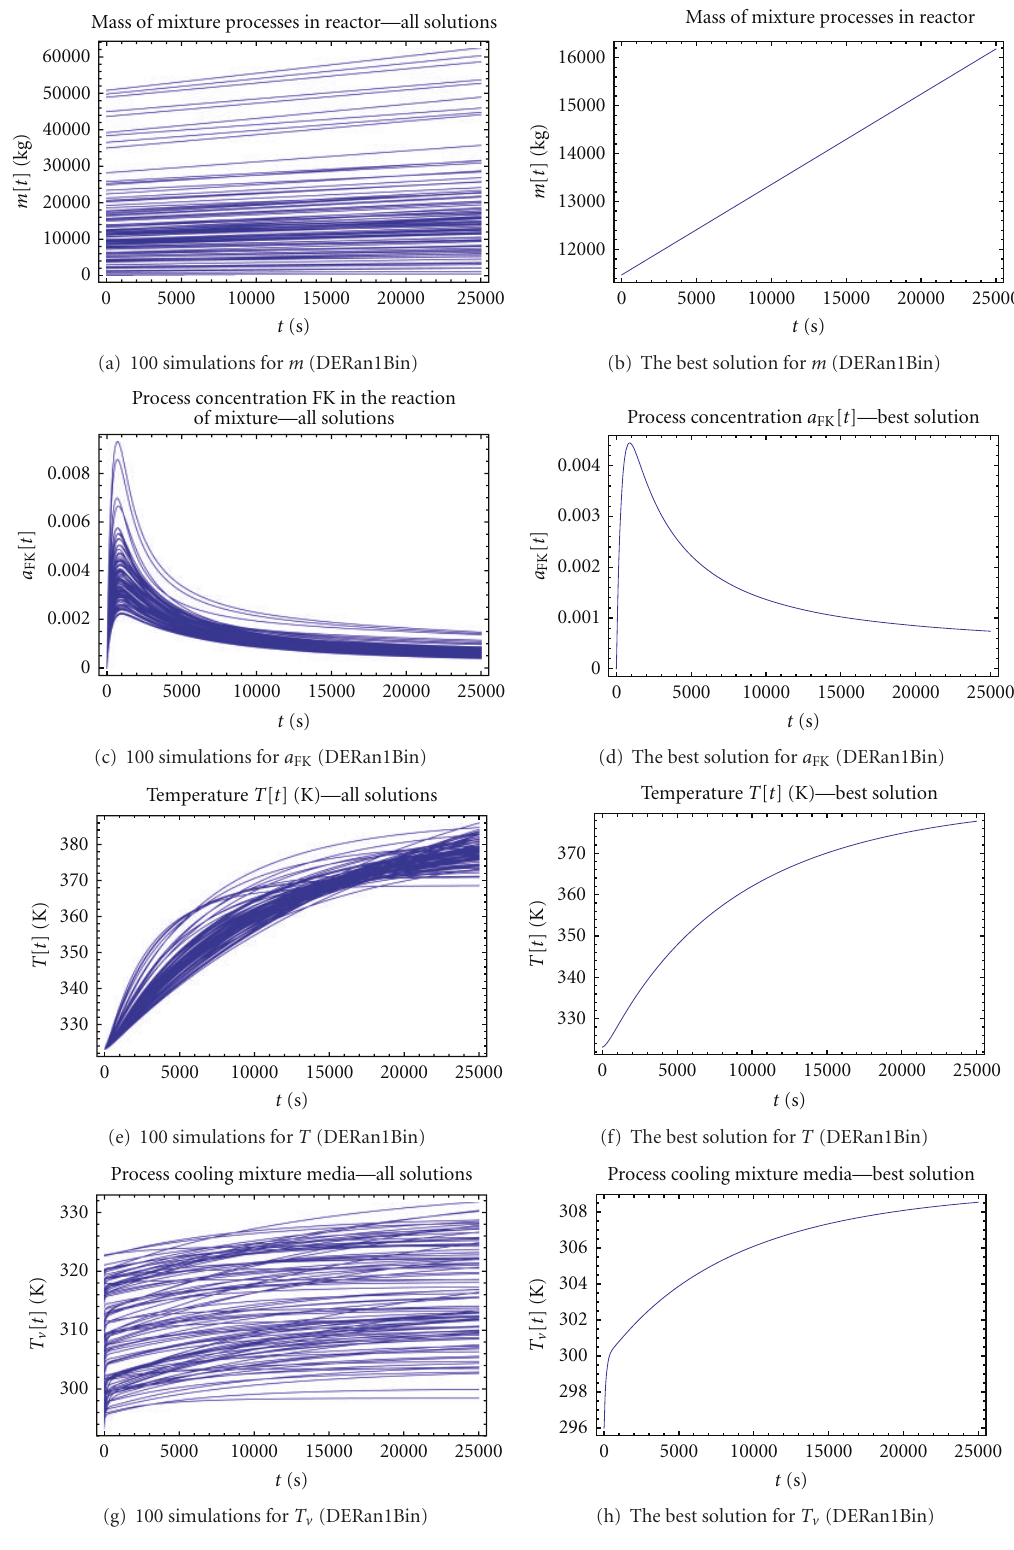
Figure 7: Processes parameters for 100 simulations of DE—version